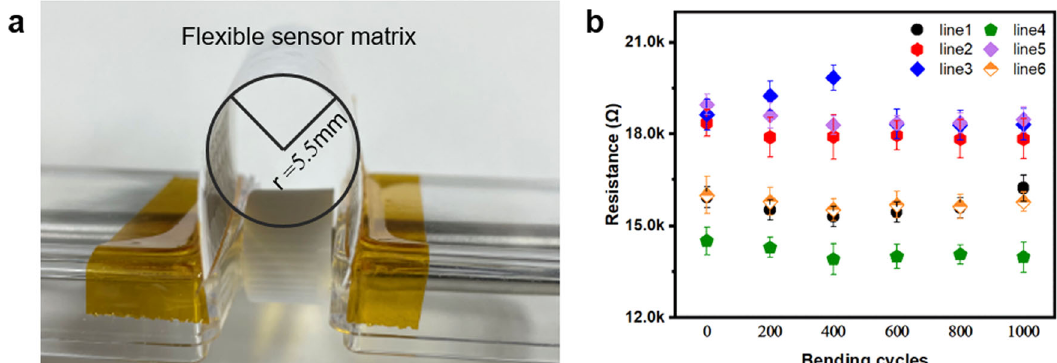
Fig. 7 Characterization of the sensor matrix using bending tests. a Photograph of a fl exible sensor matrix. b Variations in resistance as a function of the number of bending